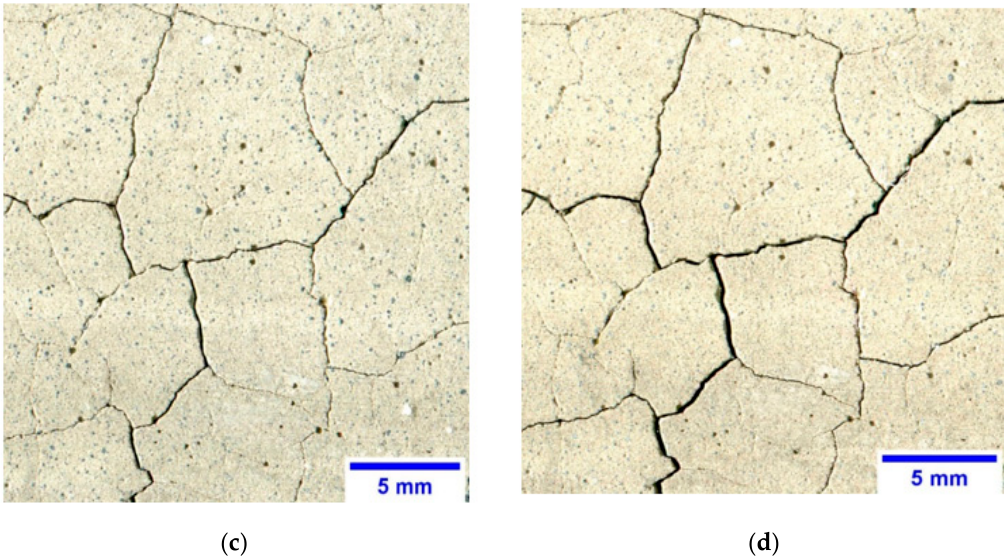
Figure 1. The cracking pattern visible on the surface of the cement matrix with w/c = 0.55: ( a ) CP32.5—the first phase of thermal load; ( b ) CP32.5—the second phase of thermal load; ( c ) CP32.5 + M—the first phase of thermal load; ( d ) CP32.5 + M—the second phase of thermal load.